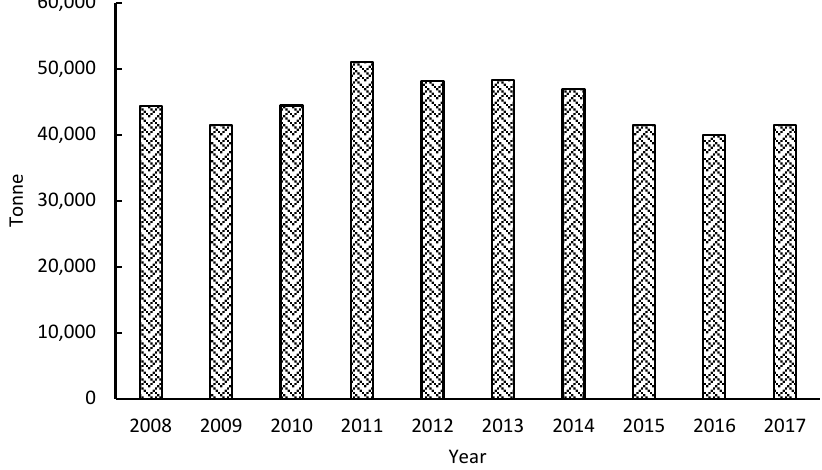
Figure 2. Ten years of sago starch export statistics for Sarawak, Malaysia, 2008–2017 [62].